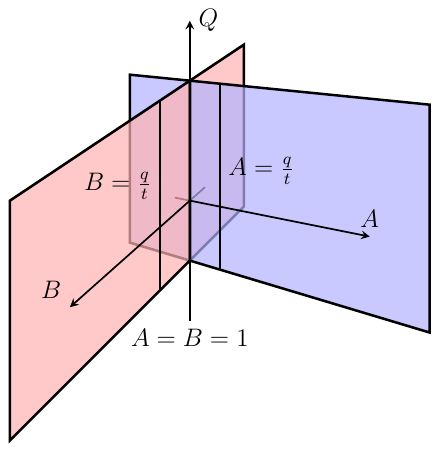
Figure 6 . Schematic representation of the topological loci inside the K(cid:127)ahler moduli space of the strip geometry which can also be thought of as Coulomb moduli space of the gauge theory. The moduli space is parametrized by Q , A and B , which are transformed into Q 1 , Q 2 and Q F using q t the formulas Q 1 = A , Q 2 = p q B (cid:0) 1 , Q F = p q ( QA ) (cid:0) 1 . There are two distinct topological q t t loci, f A = 1 g and f B = 1 g (shown in red and blue respectively), which intersect on the line A = B = 1. There are also two special lines, A = q and B = q , each on its own locus, where and t t (cid:0) q (cid:1) (cid:6) 1 Q 1 = Q 2 = . In the unre(cid:12)ned limit t ! q the special lines coalesce with the intersection of t the two